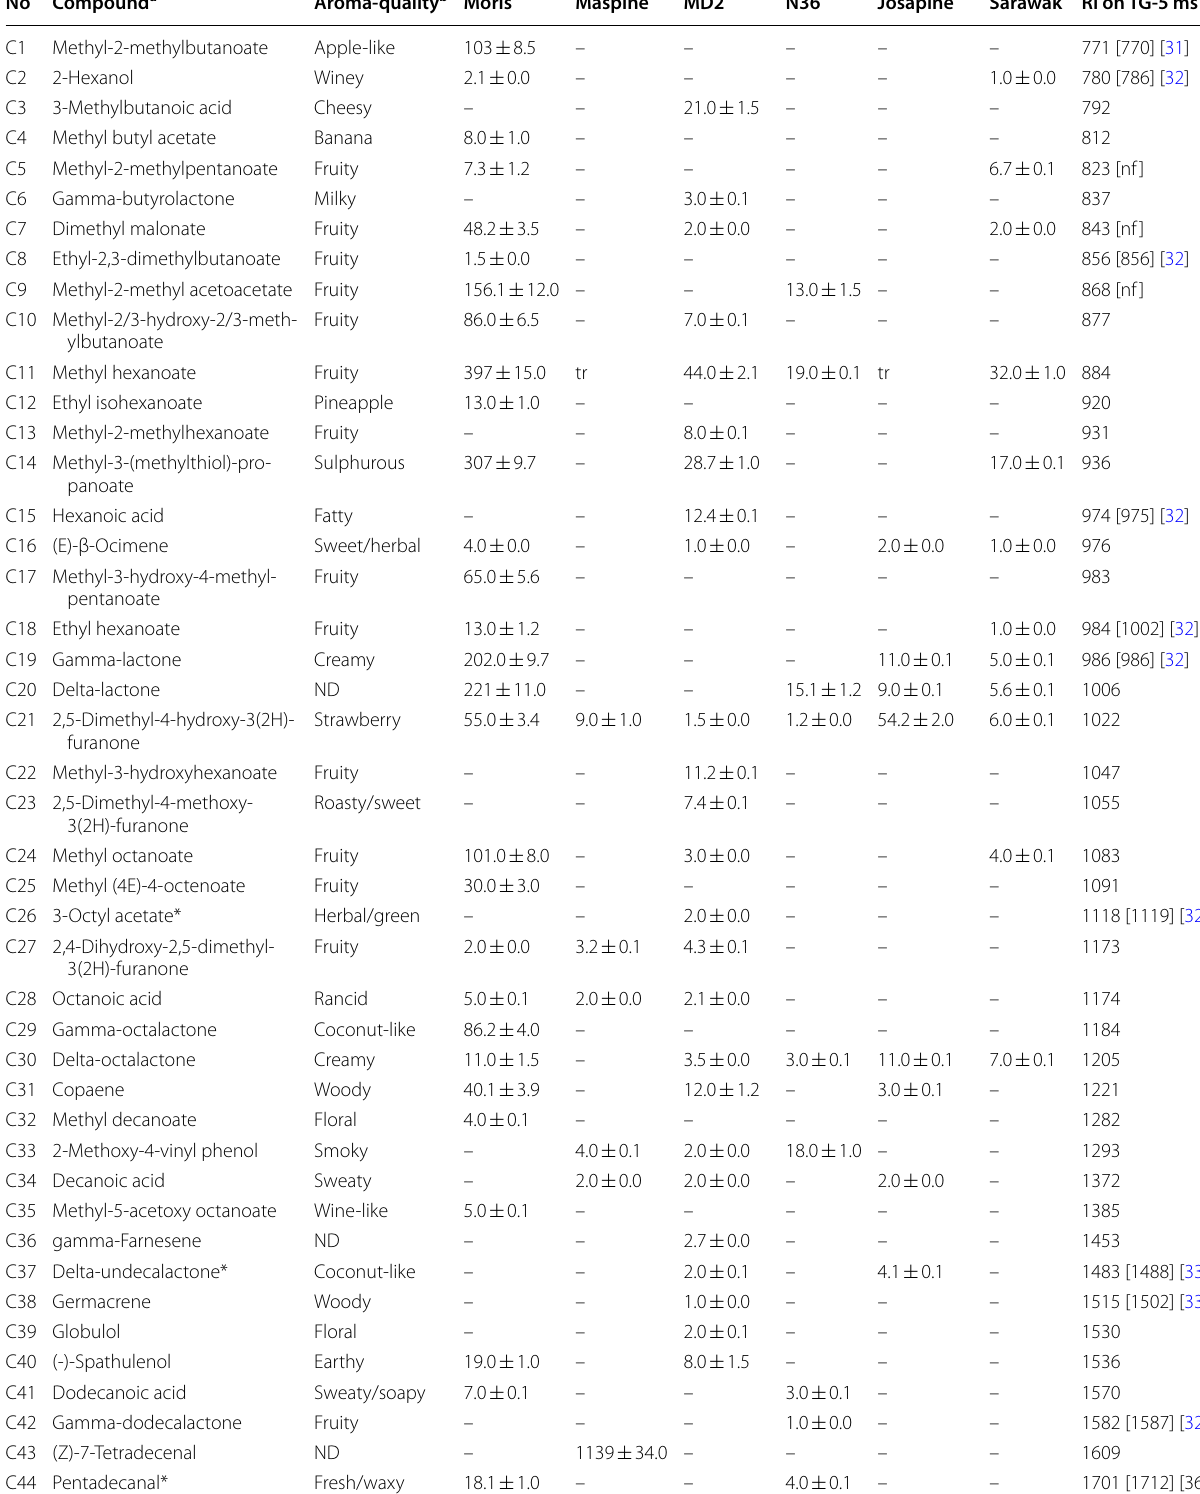
Table 2 Detected aroma compounds with retention index and mean concentration (µg/kg fresh fruit) found in each pineapple varieties grown in Malaysia No Compound